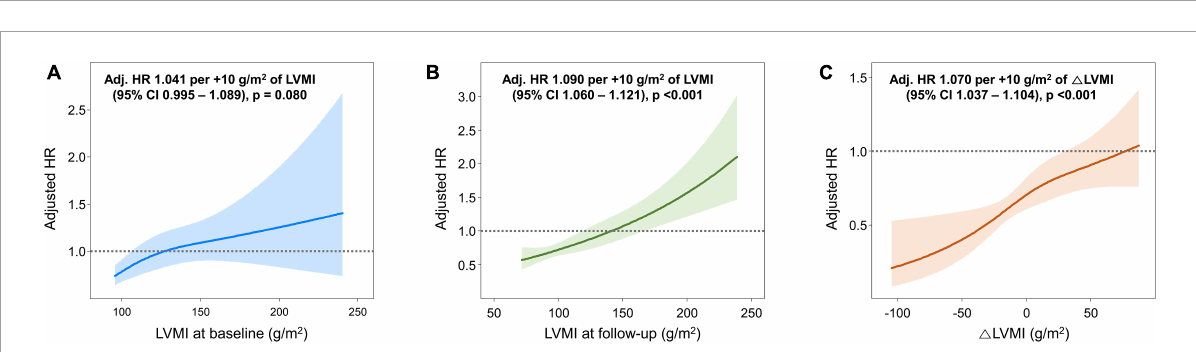
FIGURE3 Associations between LVMI and the risk of the composite study outcome. Spline curves showing the adjusted HR for the composite study outcome according to (A) LVMI at baseline, (B) LVMI at follow-up, and (C) (cid:77) LVMI [(LVMI at follow-up) – (LVMI at baseline)]. HR, hazard ratio; LVMI, left ventricular mass